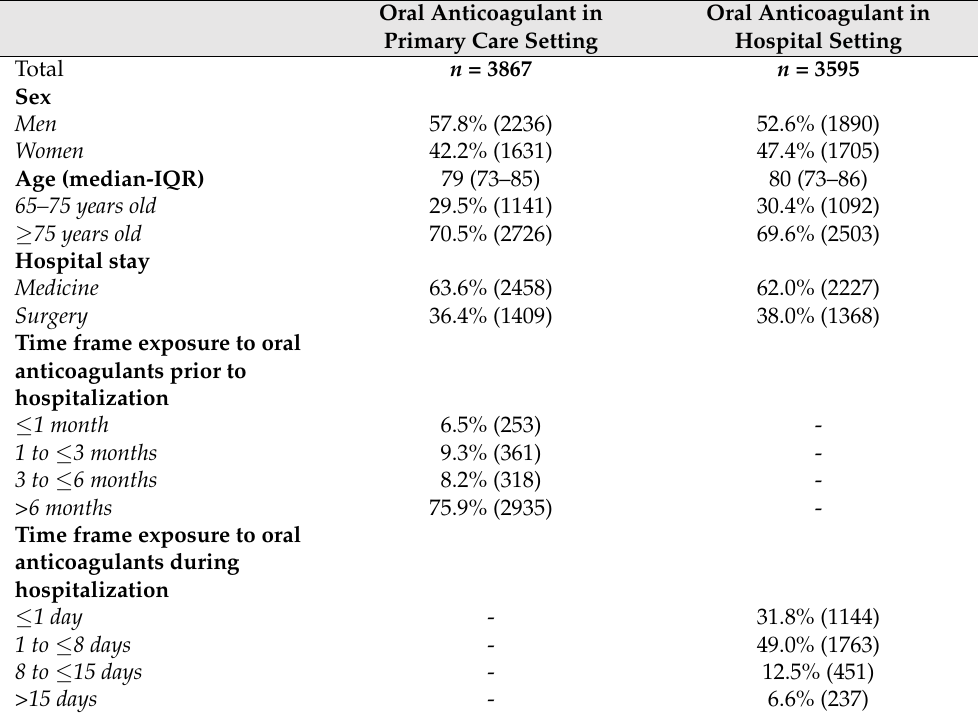
Table 1. General characteristics of the hospitalized patients in both settings (primary care and hospital